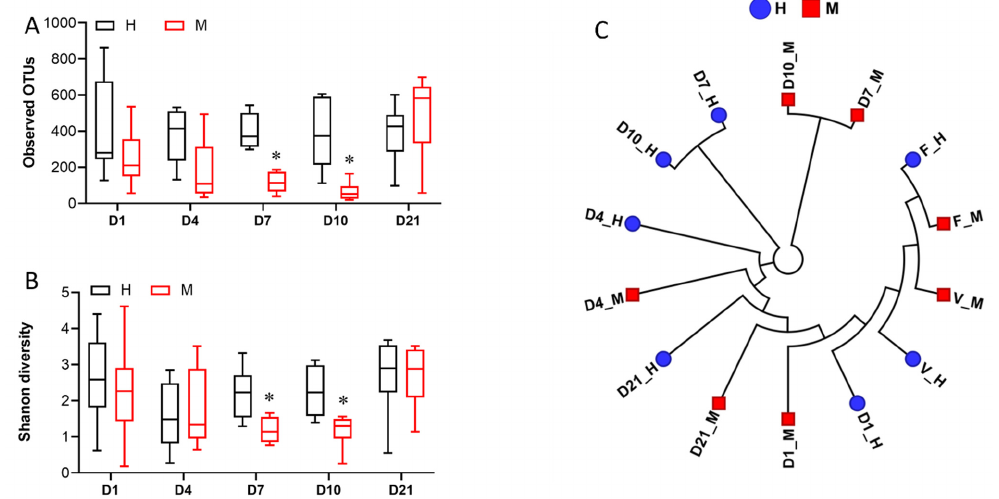
Figure 3. Comparison of microbial species diversity and taxonomic composition between postpartum uterine microbiomes in metritis (M) and healthy (H) animals. Box plots showing microbial community species richness and alpha diversity based on ( A ) observed OTUs and ( B ) Shannon diversity index, respectively. * Indicates statistically significant ( p < 0.05; Kurskall Wallis test) differences be- tween M and H animals’ alpha diversities. ( C ) Hierarchal clustering cladogram showing similarities between M and H uterine microbiomes based on averaged taxa presence and absence composition of uterine microbiomes of animals from each group.